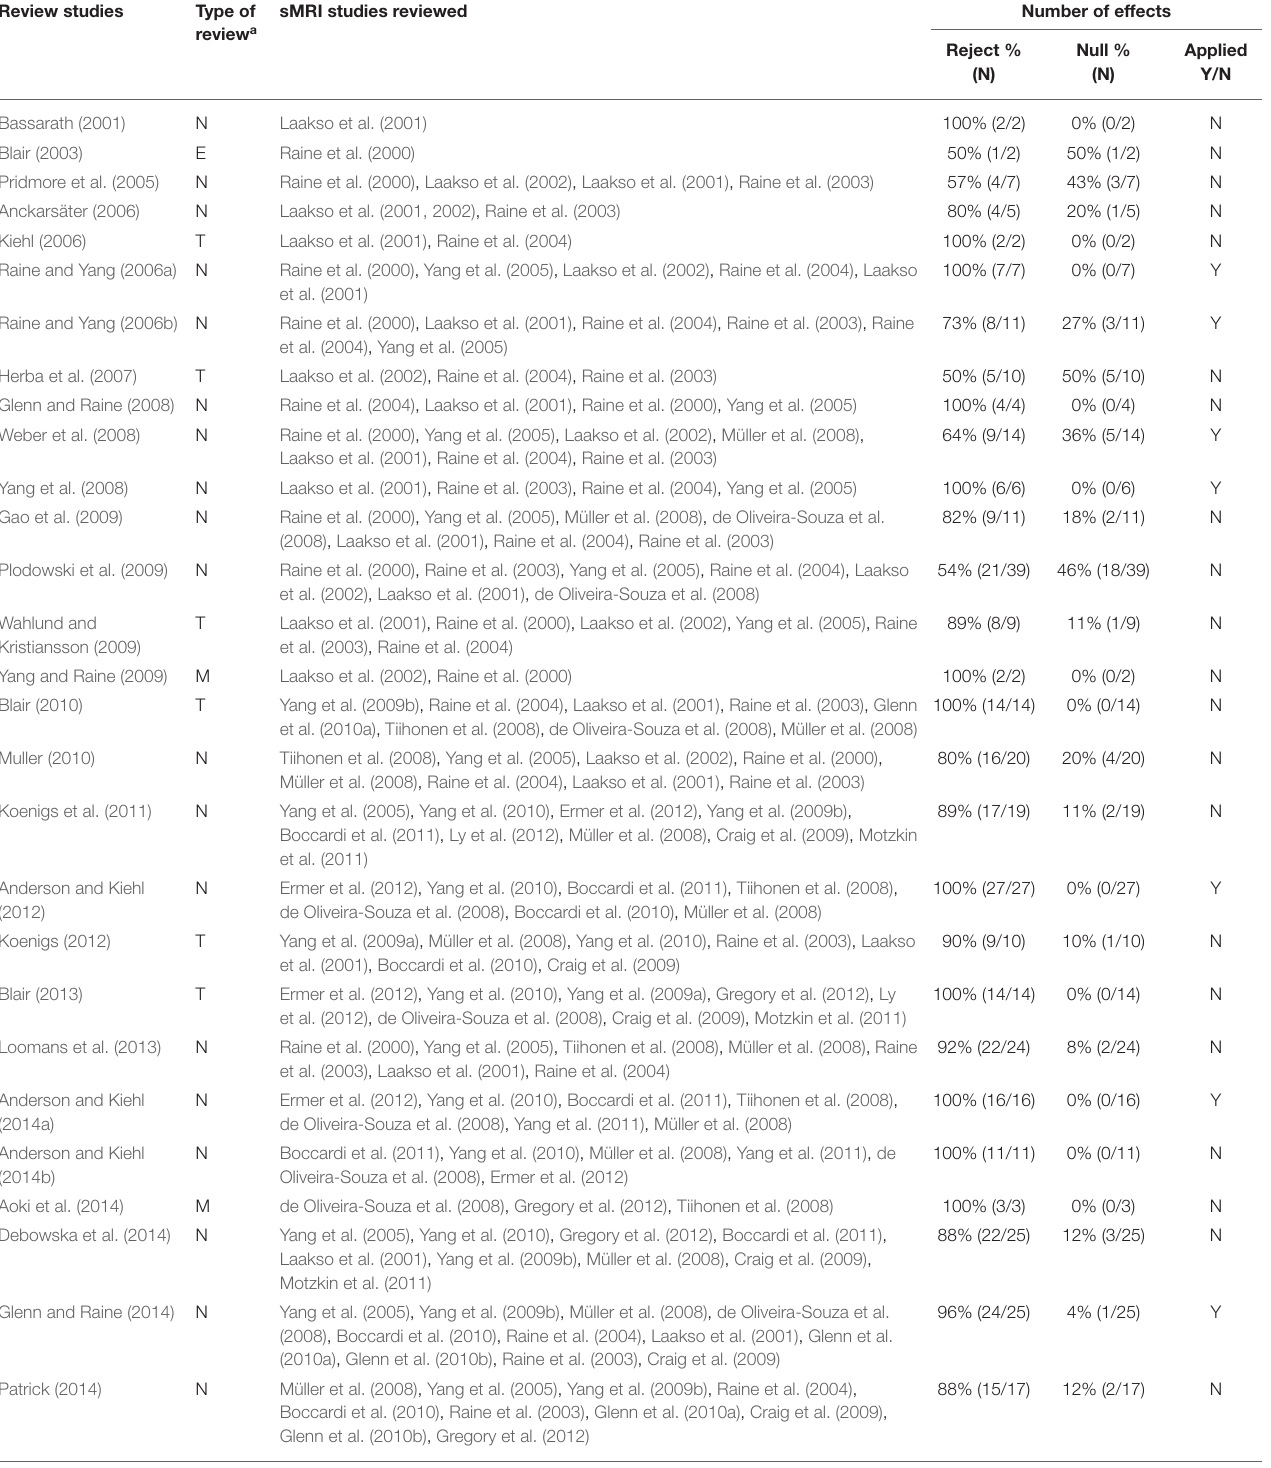
TABLE 2 | Summary of review study